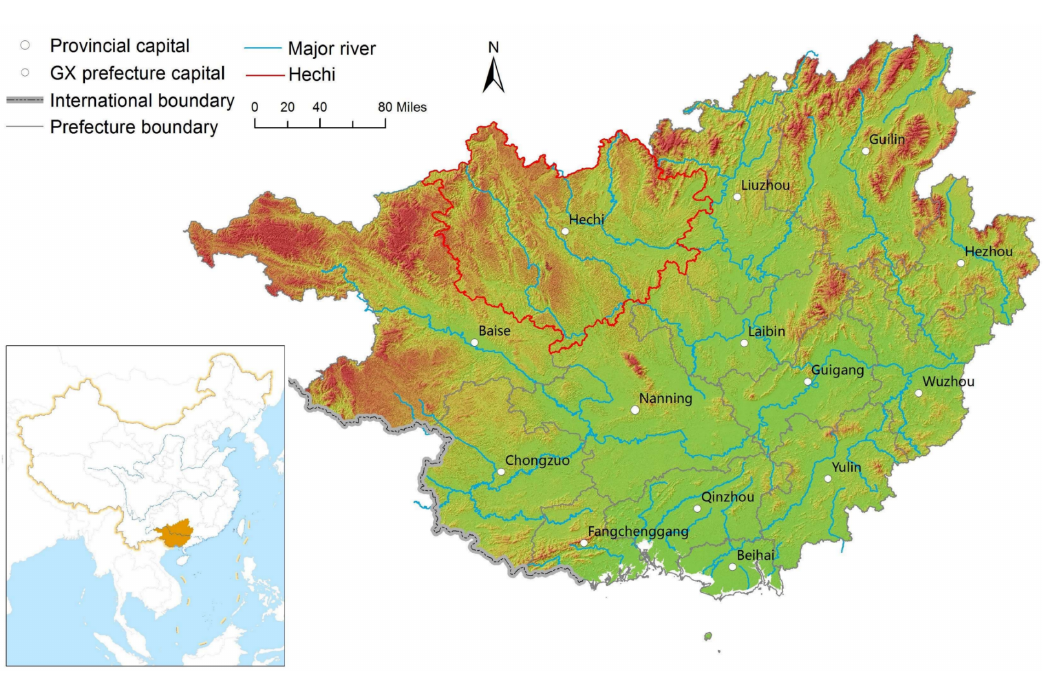
Figure 1. Case study